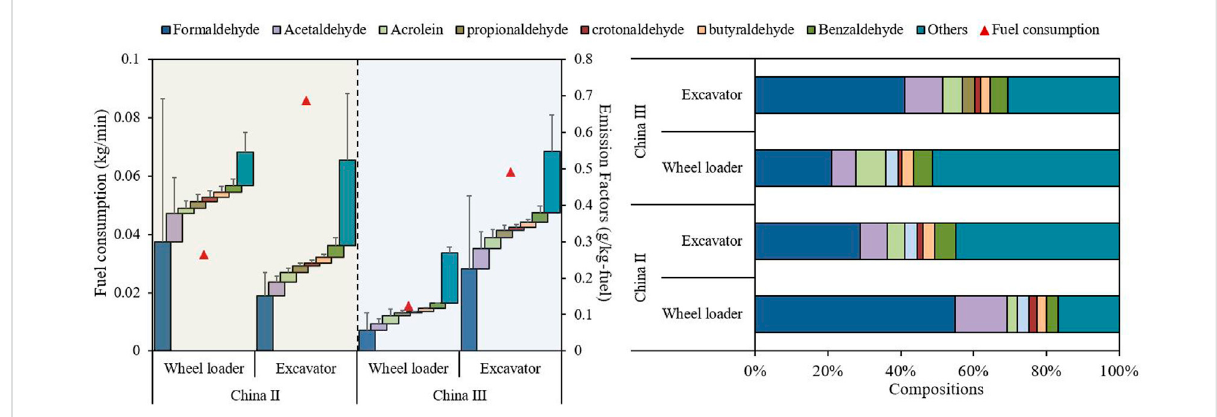
In fl uence of the machinery type on the carbonyl compound emission factors under the different emission